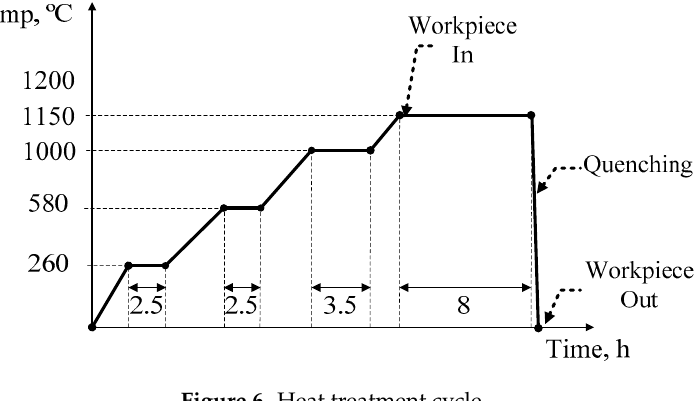
Figure 6. Heat treatment cycle.